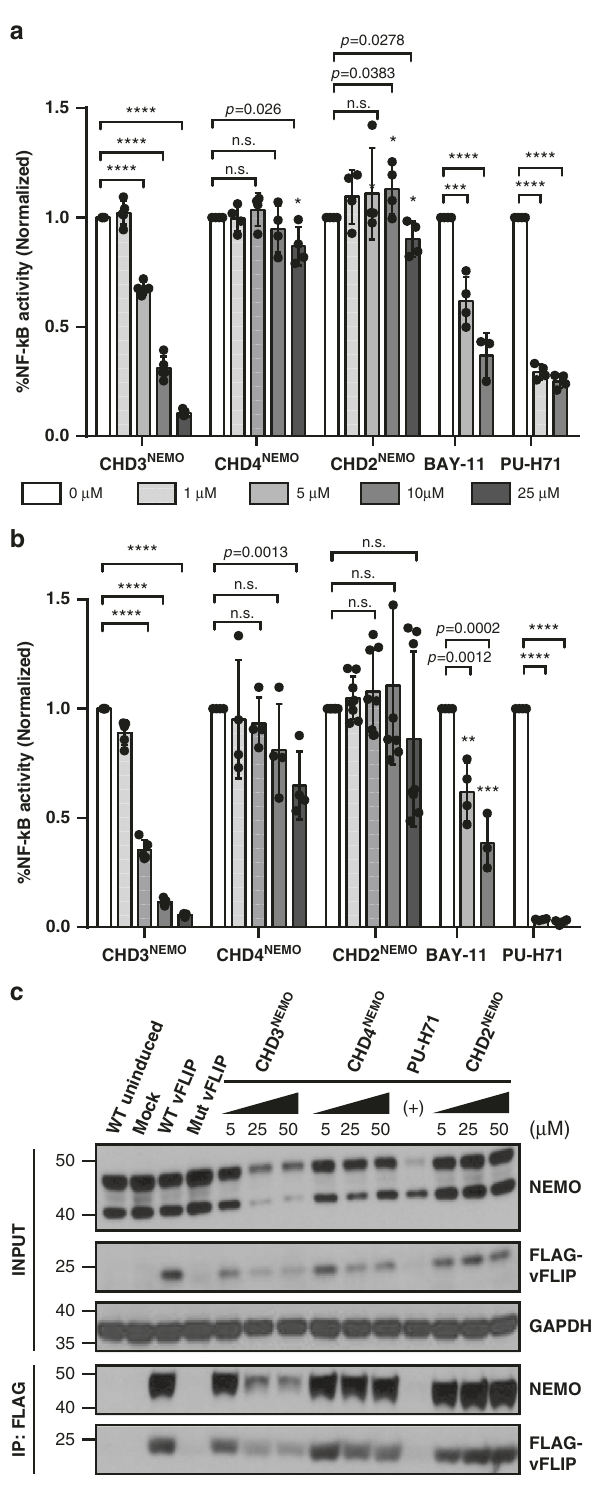
CHD3 NEMO disrupts vFLIP/NEMO complex formation in lymphoma cells . We next used co-immunoprecipitation studies to investigate whether CHD3 NEMO disrupted vFLIP/NEMO complex formation. We used a Namalwa Burkitt lymphoma cell line, which was stably transfected with the tetracycline-inducible FLAG-tagged wildtype (WT vFLIP) or mutant (Mut vFLIP) plasmids. We used Mut vFLIP as a positive control since it is an